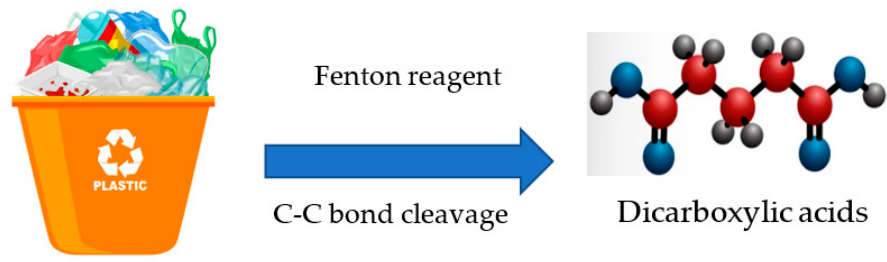
Figure 5. Plastic waste treatment via Fenton oxidation process .